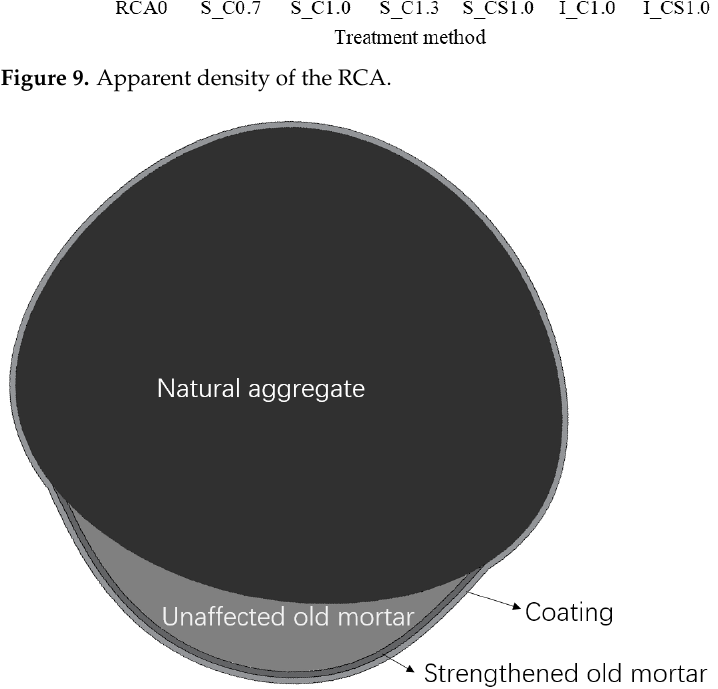
Figure 10. Schematic of the treated